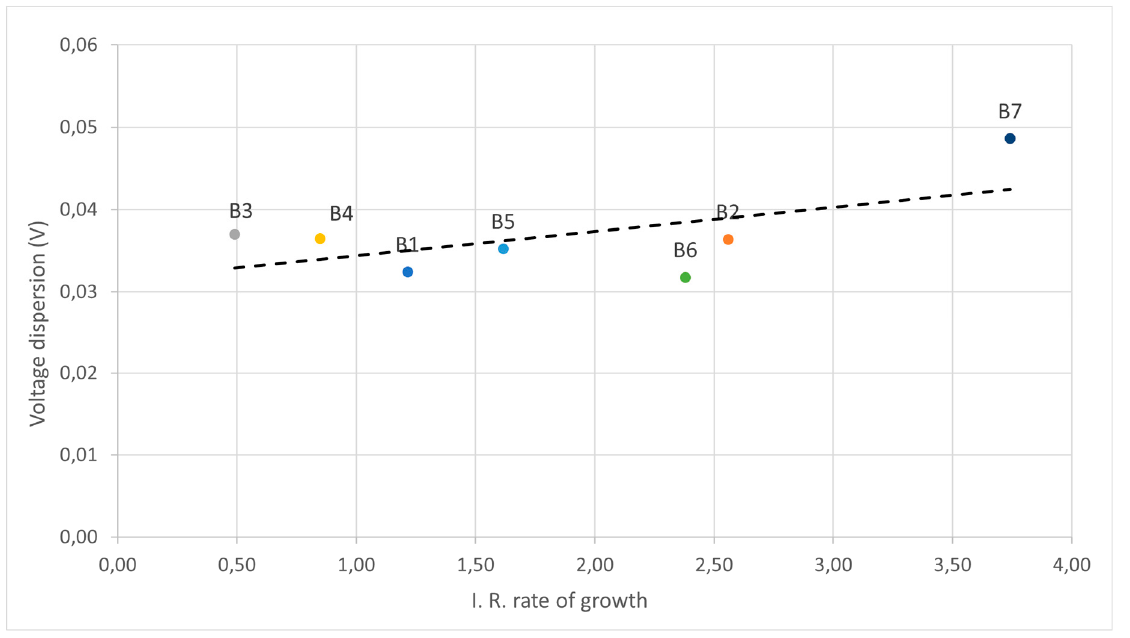
Figure 12. Voltage dispersion vs. internal resistance growth.